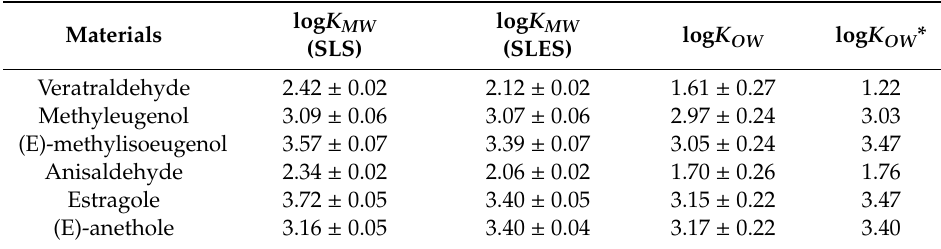
Figure 4. The e ff ect of SLS concentration on the UV absorption spectrum of veratraldehyde: ( a ) experimental UV spectra; ( b ) di ff erential UV spectra; ( c ) variation of absorbance at selected wavelengths; ( d ) fitted UV spectra. Table 2. The logarithmic values of the calculated values of micelle-water, K MW , and octanol-water, K OW , partition coe ffi cients for the studied fragrance materials as well as those taken from the literature, K OW * [32,33] (the uncertainties of K MW values correspond to the standard errors of parameters obtained from the fits, while those of K OW were calculated with ACD / ChemSketch 2012 (ACD Labs, Toronto, ON,